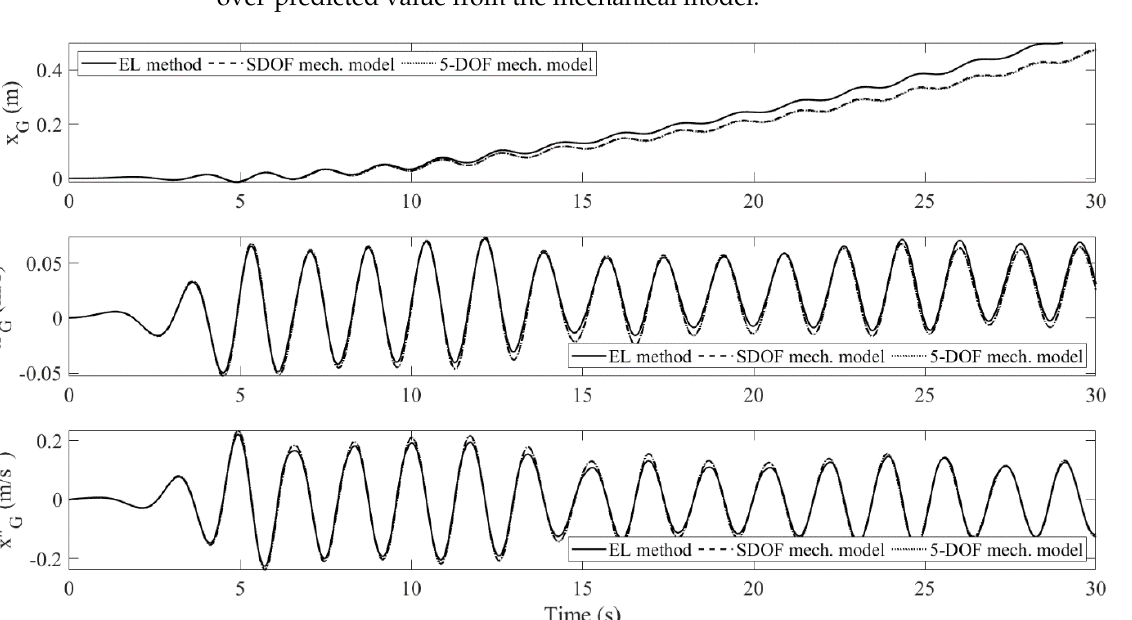
Figure 9. The horizontal forces acting on the floating body for the large-wave case. The heave motion responses of the floating body and the vertical resultant forces to the body are shown in Figures 10 and 11, respectively. The mean value of the steady-state displacement was −0.0043 m, which was the same as the static displacement. The re- sponses by both methods were identical except for the sloshing force. The mechanical model assumes the vertical sloshing force as a dead load, while the EL method takes the dynamic force due to the momentum change and convective acceleration into account. However, this effect was not significant in the vertical direction. It only caused a 3% (10 N) deviation from the dead load. Therefore, the heave response remained the same.